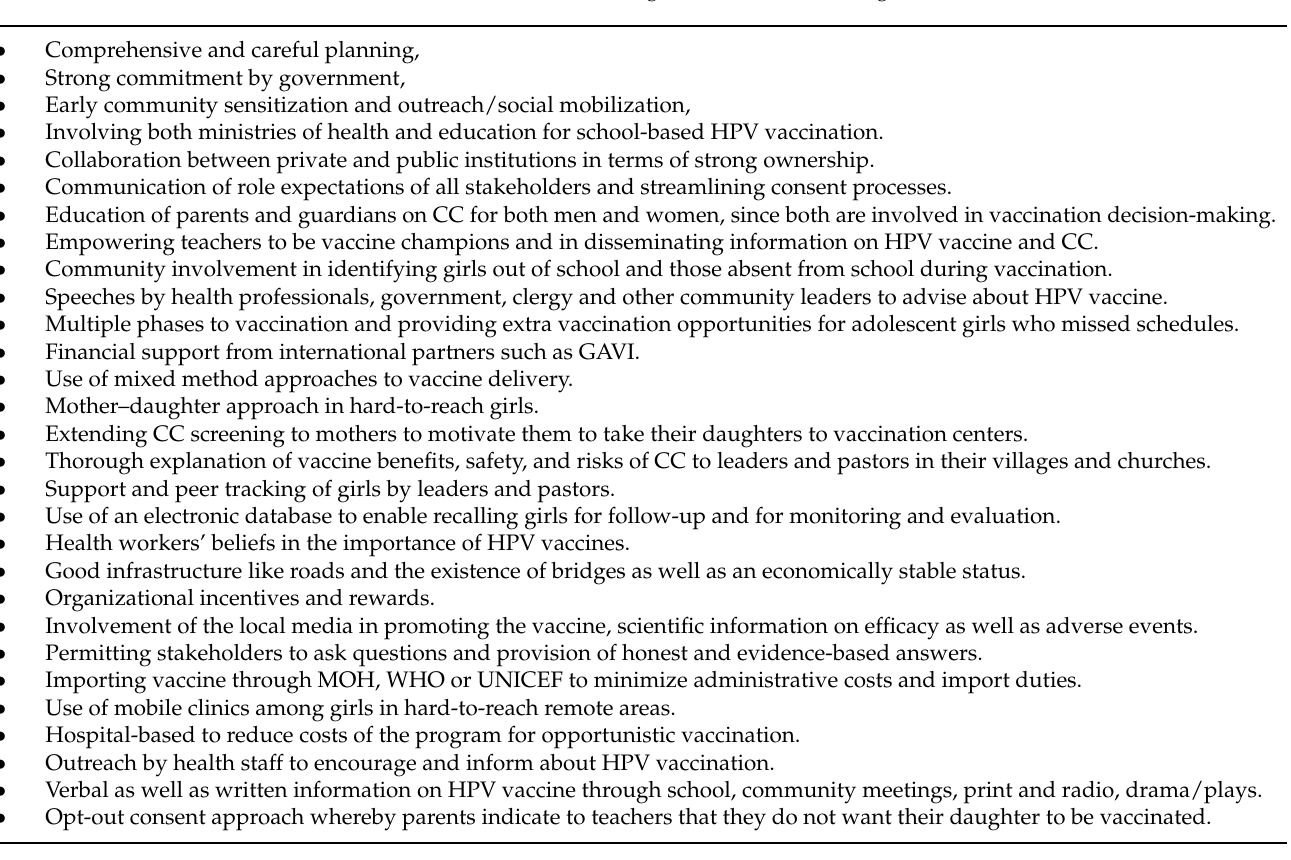
Table 1. Factors associated with high HPV vaccine coverage.